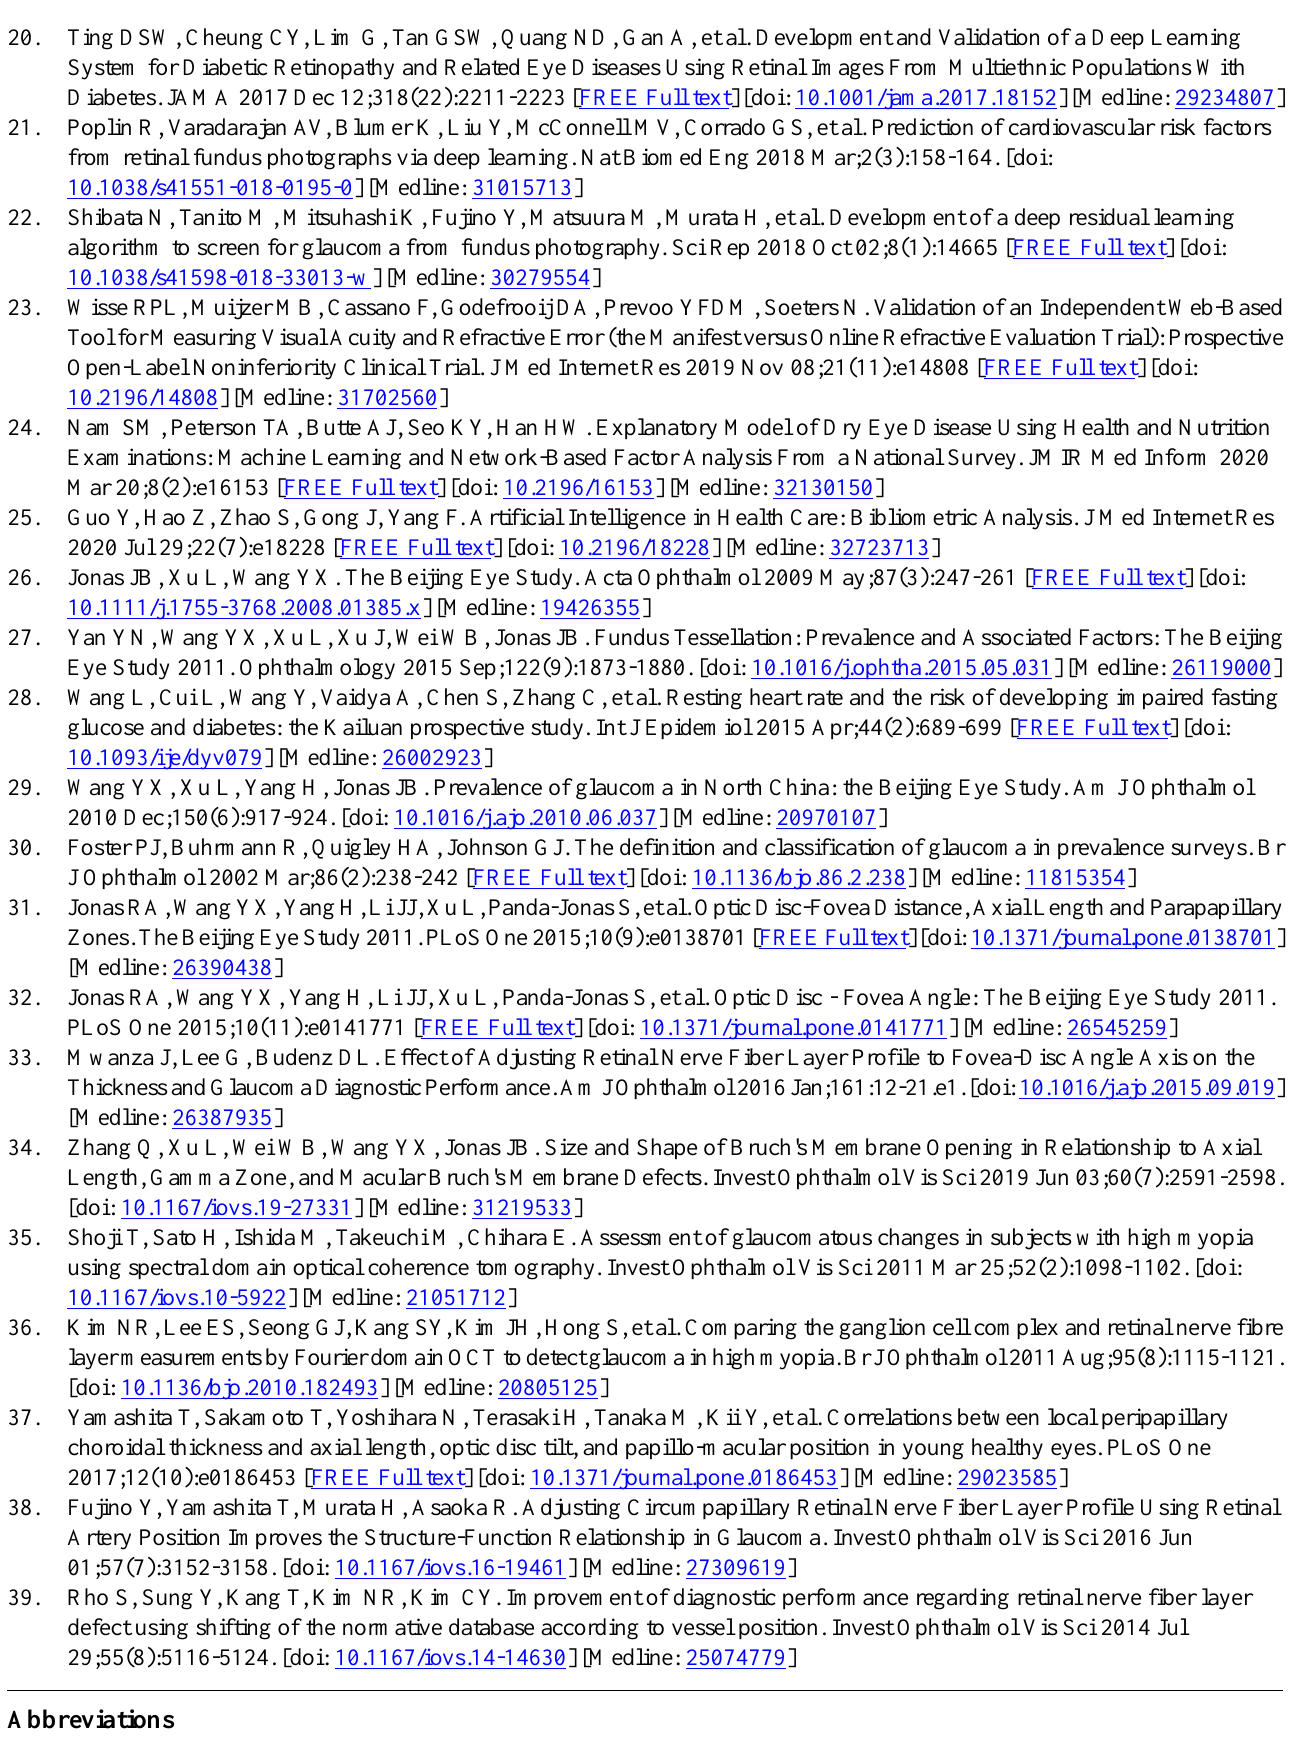
AUROC: area under the receiver operating characteristic